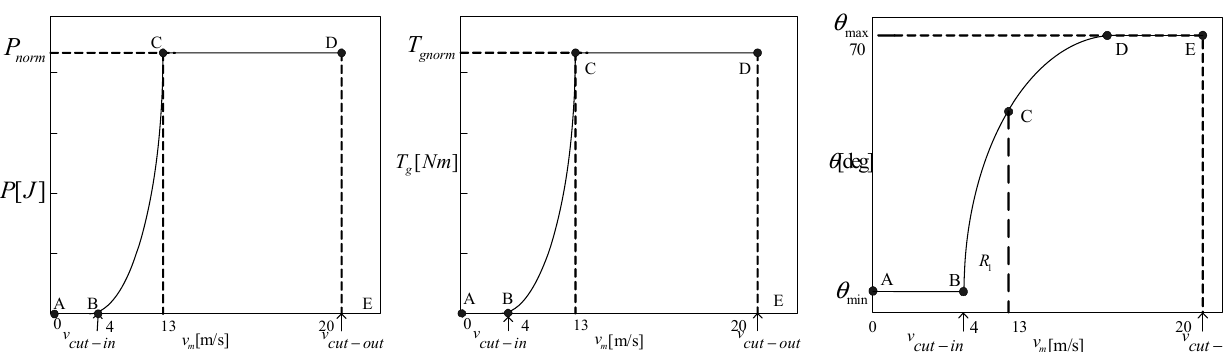
Figure 3. The tendency of the (cid:2010) , (cid:1846)